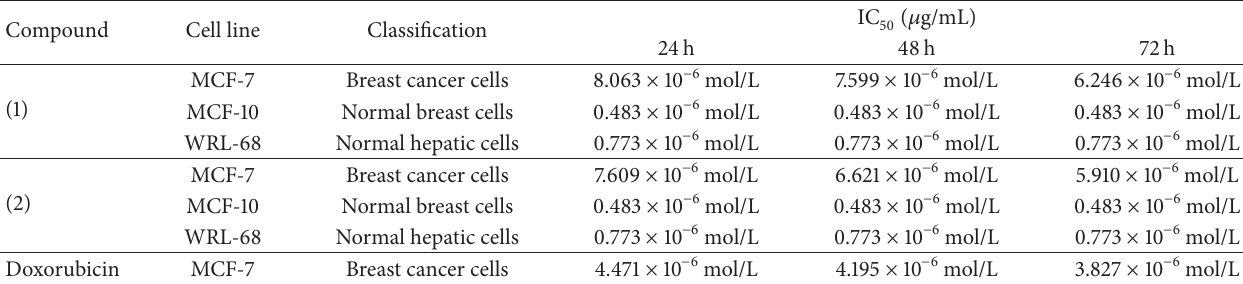
concentration of the quinazolinone-based compounds against MCF-7, MCF-10, and WRL-68 cell lines after 24, 48, and Table 2: The IC 50 72